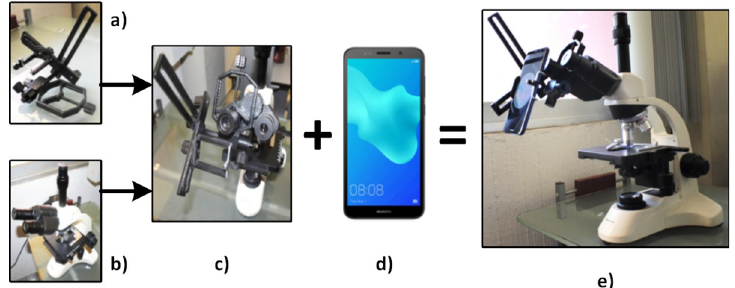
Fig 4. Smartphone mounting: a) Adapter, b) Optical microscope, c) Adapter-Microscope mounting, d) Smartphone, e) Image capture